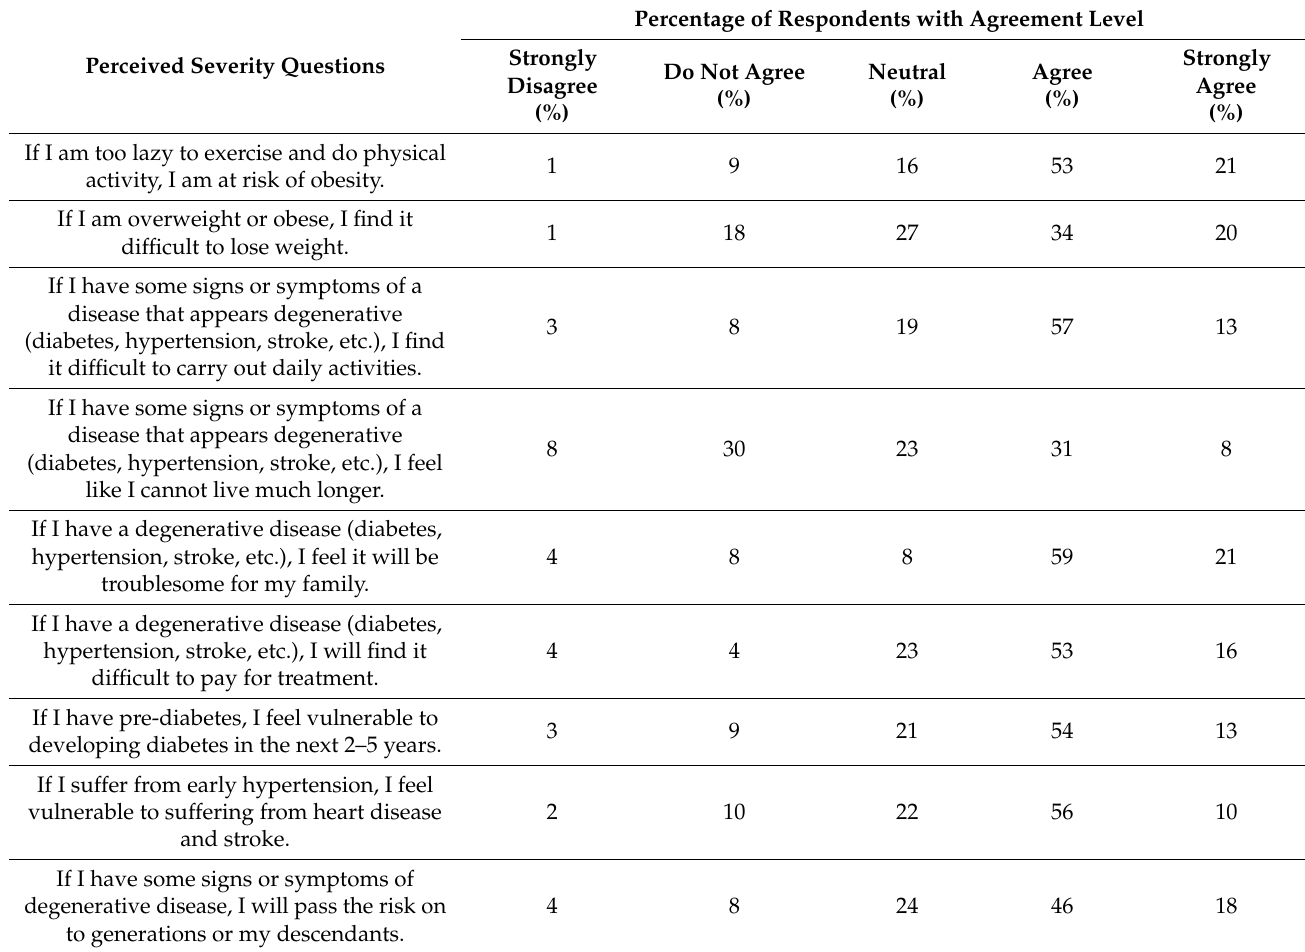
Table 5. Perceived severity